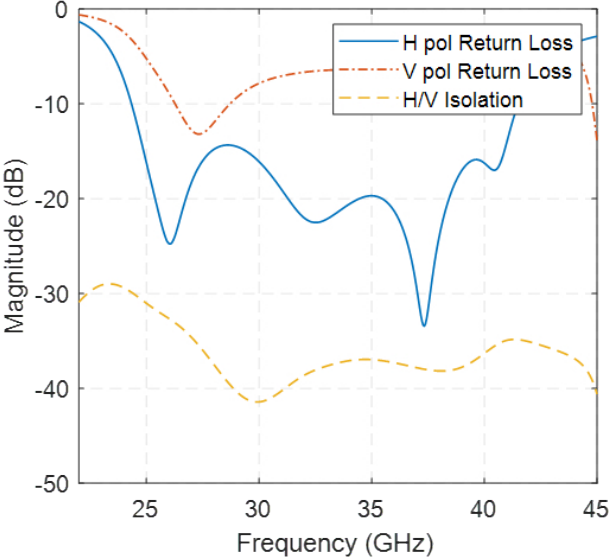
Figure 4. H and V polarization return loss and H/V isolation after second step of